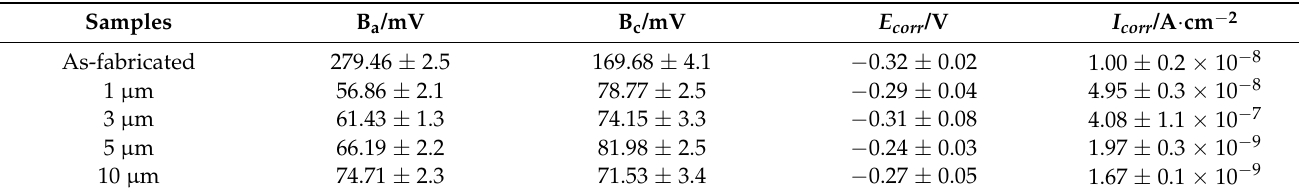
Table 2. Corrosion parameters extracted from the Polarization curves.